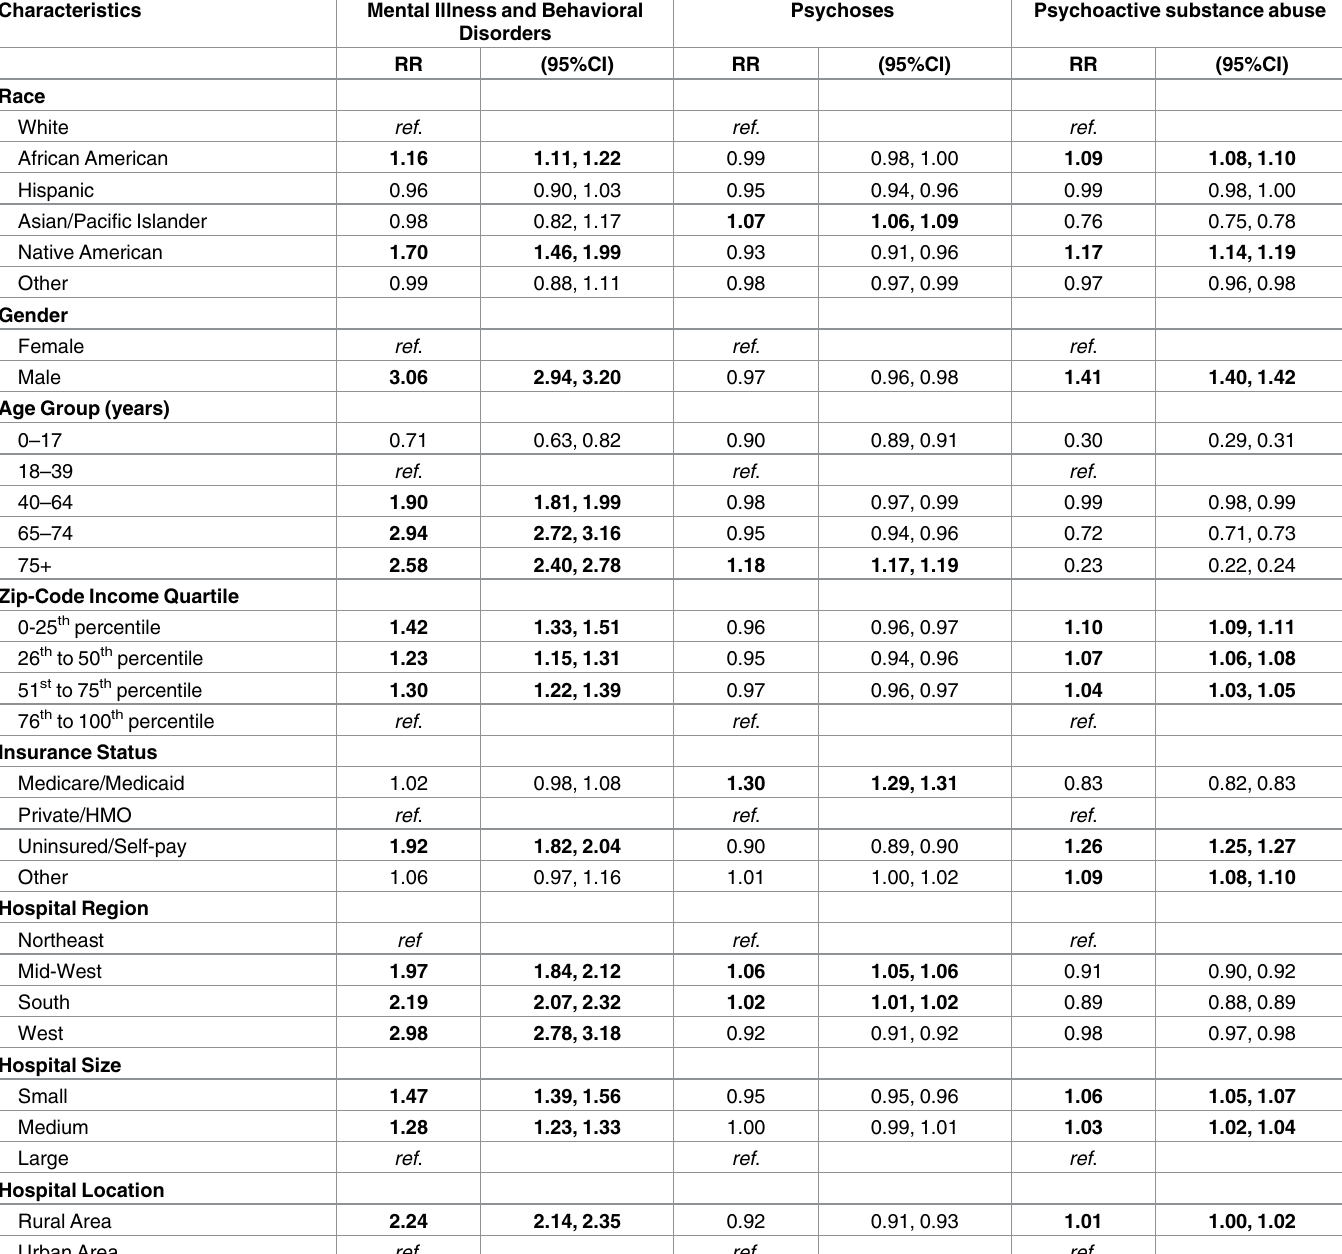
Table 3. Multivariable model of risk factors for hospitalization for all mental illness and/or behavioral disorders, psychoses, and psychoactive substance abuse with a concurrent HRI.